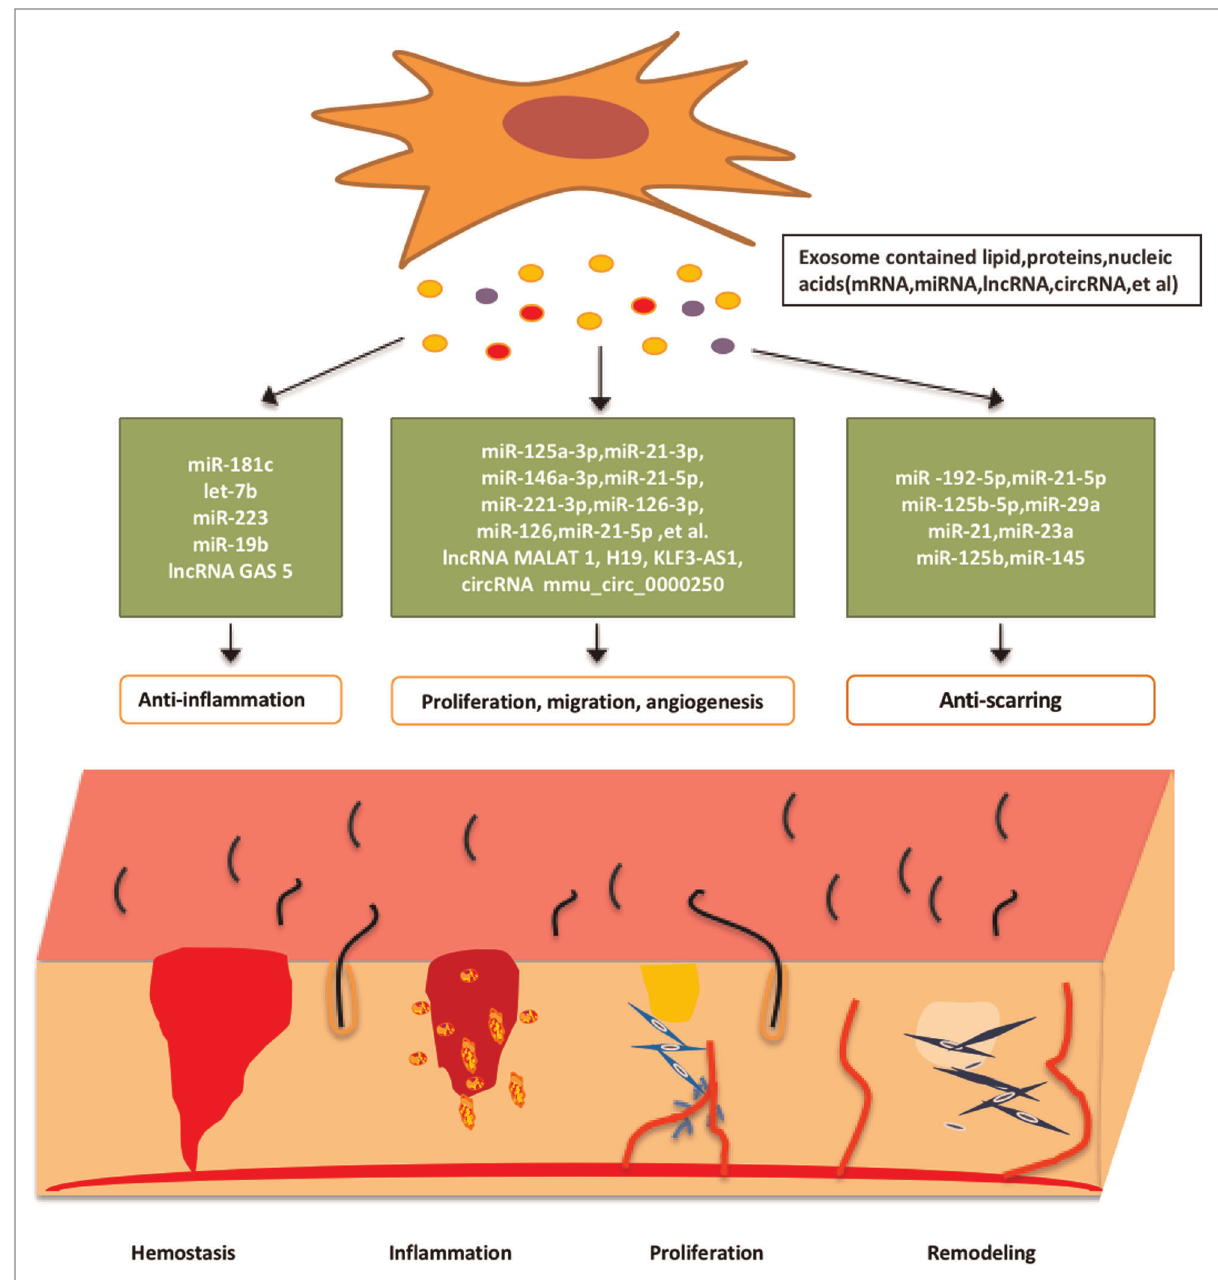
FIGURE 2 Schematic demonstration of the exosomal RNAs derived from stem cells promote wound healing by enhancing angiogenesis, cell proliferation and migration, reducing in fl ammation, and